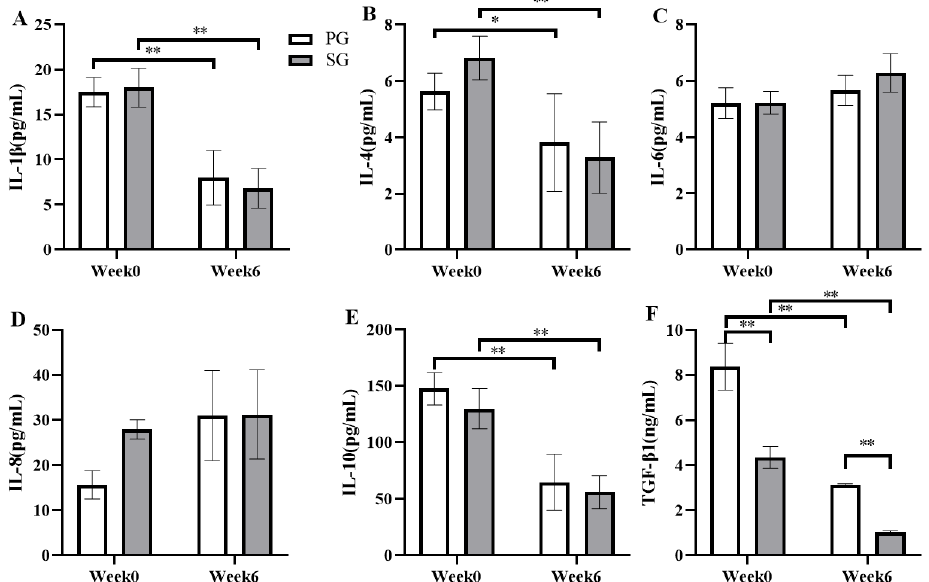
Figure 5. Comparison of the effects of the prebiotic and synbiotic on serum cytokine concentration immediately after the constant load test in elite football players. Results are presented as mean ± SEM. PG: prebiotic group (n = 15); SG: synbiotic group (n = 15). ( A ) IL-1 β concentration. ( B ) IL-4 concentration. ( C ) IL-6 concentration. ( D ) IL-8 concentration. ( E ) IL-10 concentration. ( F ) TGF- β1 concentration. *: p < 0.05; **: p < 0.01.